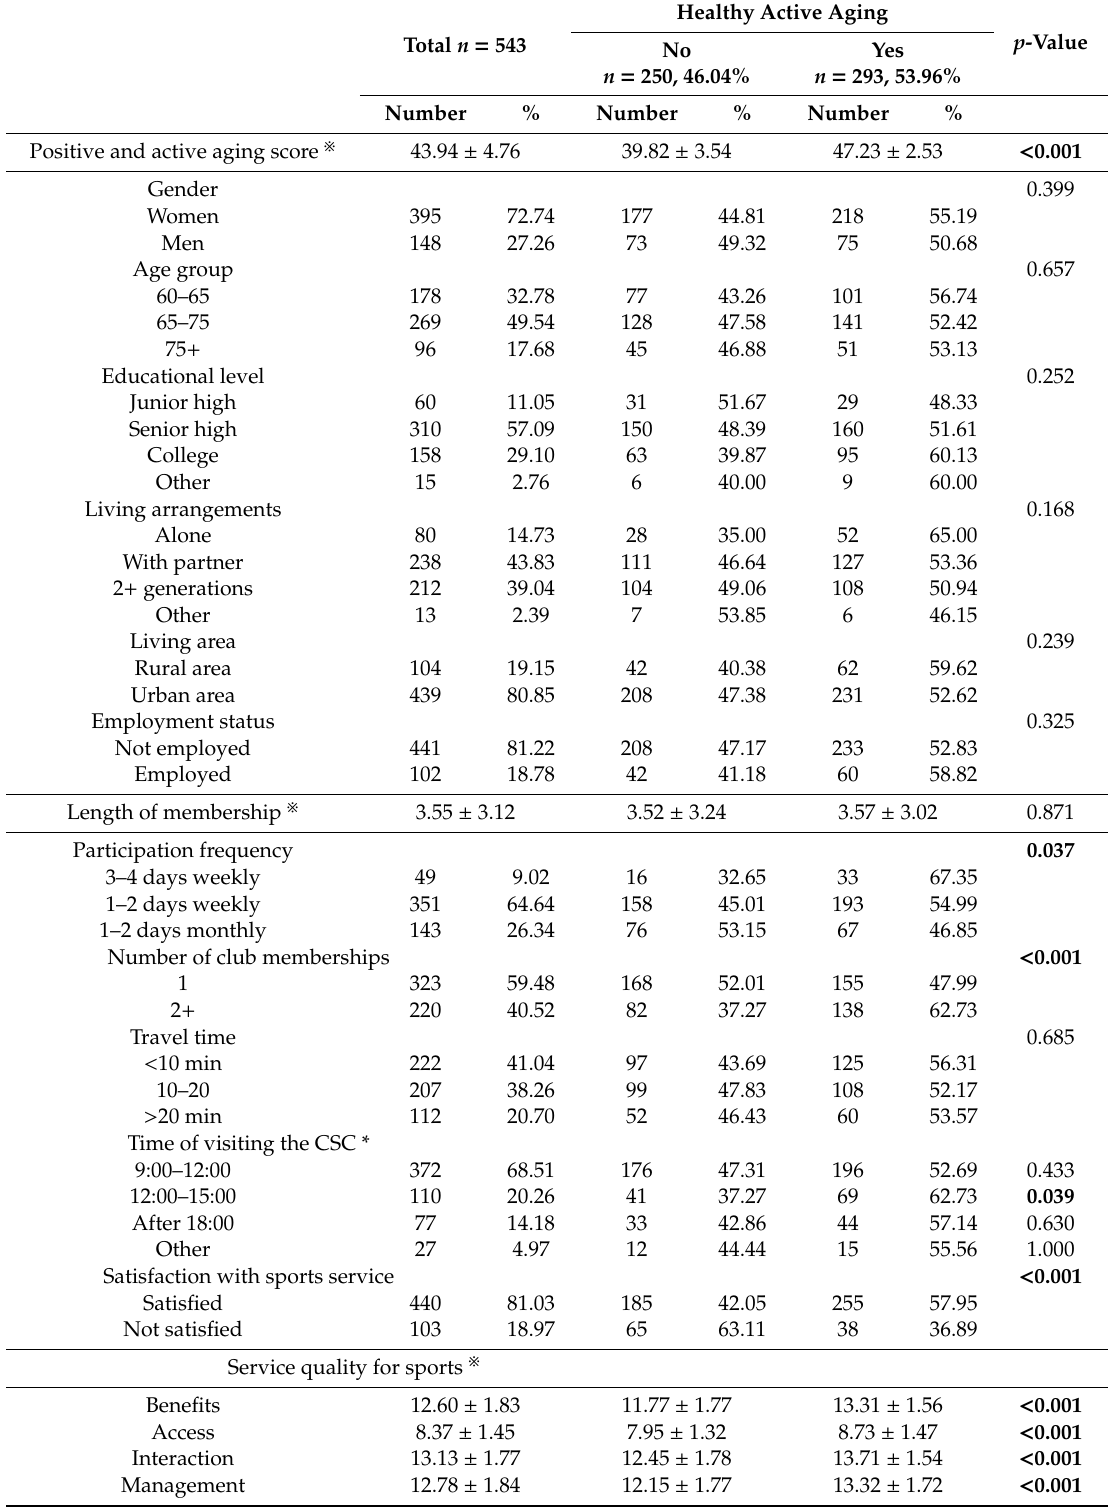
Table 1. Sociodemographic characteristics of club participants stratified by healthy active aging